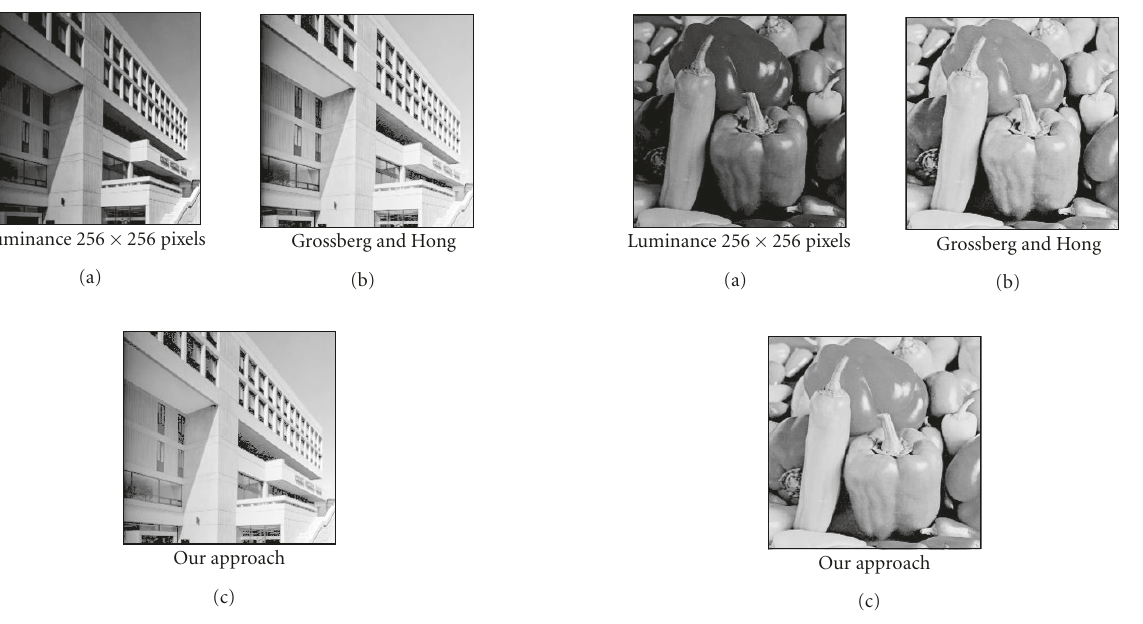
Figure 10: Power-law-stretched Peppers image : luminance values of the original Peppers image (see Figure 11) were raised to the power of 4 to create a high dynamic range image.